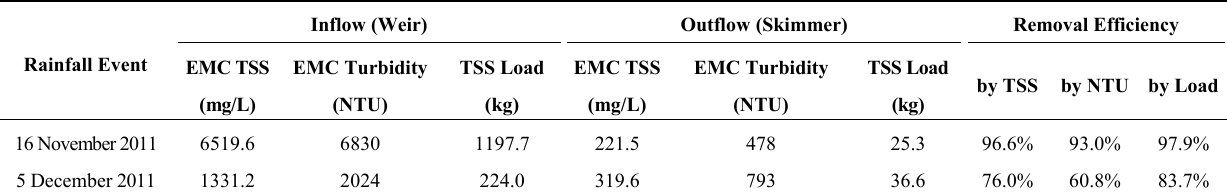
Table 2. Event mean concentration (EMC) for turbidity, TSS, and removal efficiency for two rain